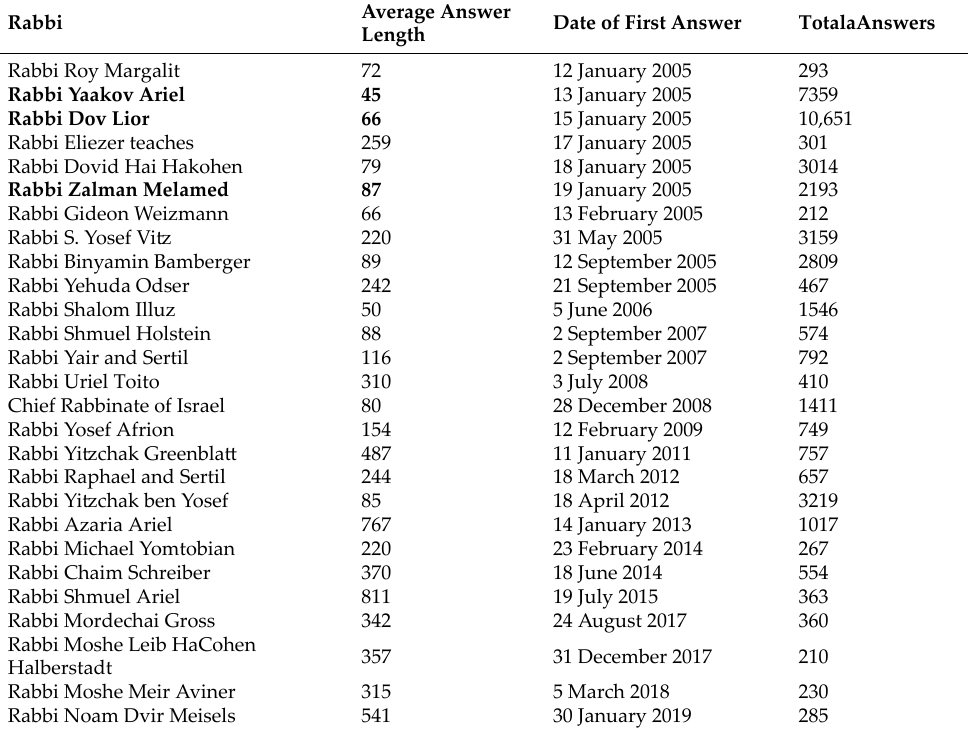
Table A3. Average Length of Responses by Rabbis Who Answered over 200 Questions. The Newer Rabbis on the Platform Provided Responses That Are More than Three Times the Average